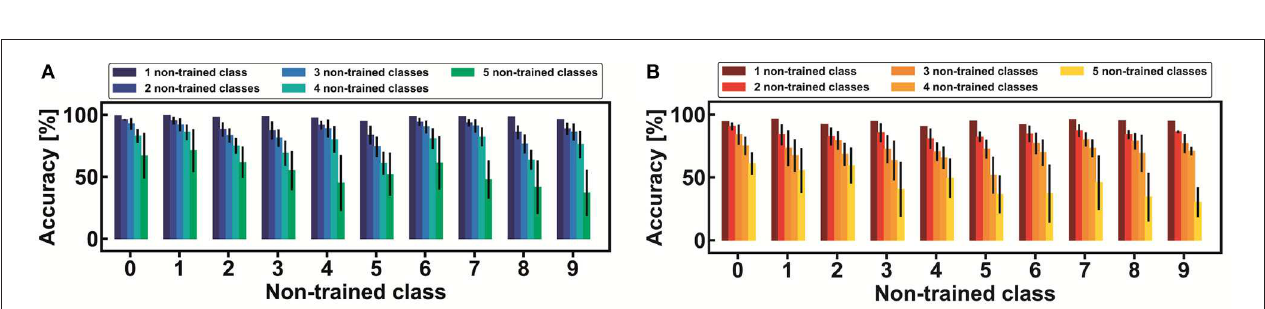
FIGURE 10 | Classification accuracy of continual learning for all the combinations of two non-trained classes of the MNIST (A) and the Fashion-MNIST (C) datasets. Note that the diagonal represents the case of only one non-trained class. Panel (B) shows the average shapes of classes 4 and 9 of the MNIST dataset. Since the shapes have common features, it is important to provide the system with a generic set of filters able to differentiate the objects joining the two classes.